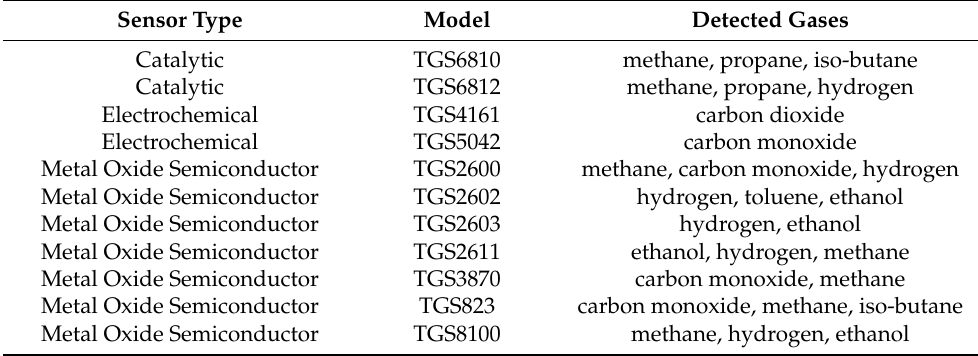
Table 3. Basic characteristics of Figaro Engineering Inc. gas sesnors.